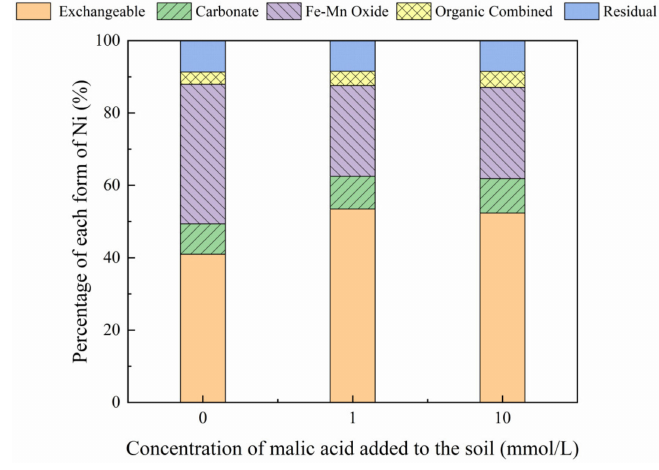
Figure 11. Distribution of different Ni forms in Ni-600 soil after the addition of malic acid (0, 1, 10